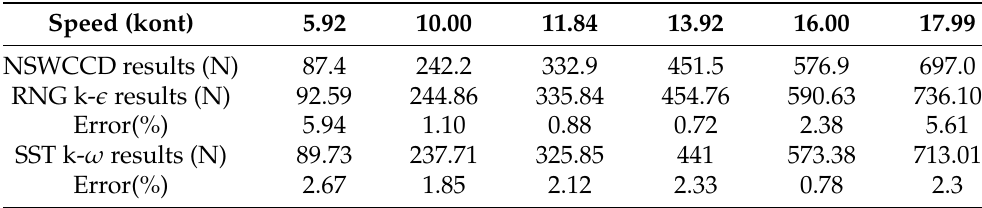
Figure 22. SUBOFF model without appendage and its computational domain. Table 4. Comparison the result of our method with that of the NSWCCD [38].